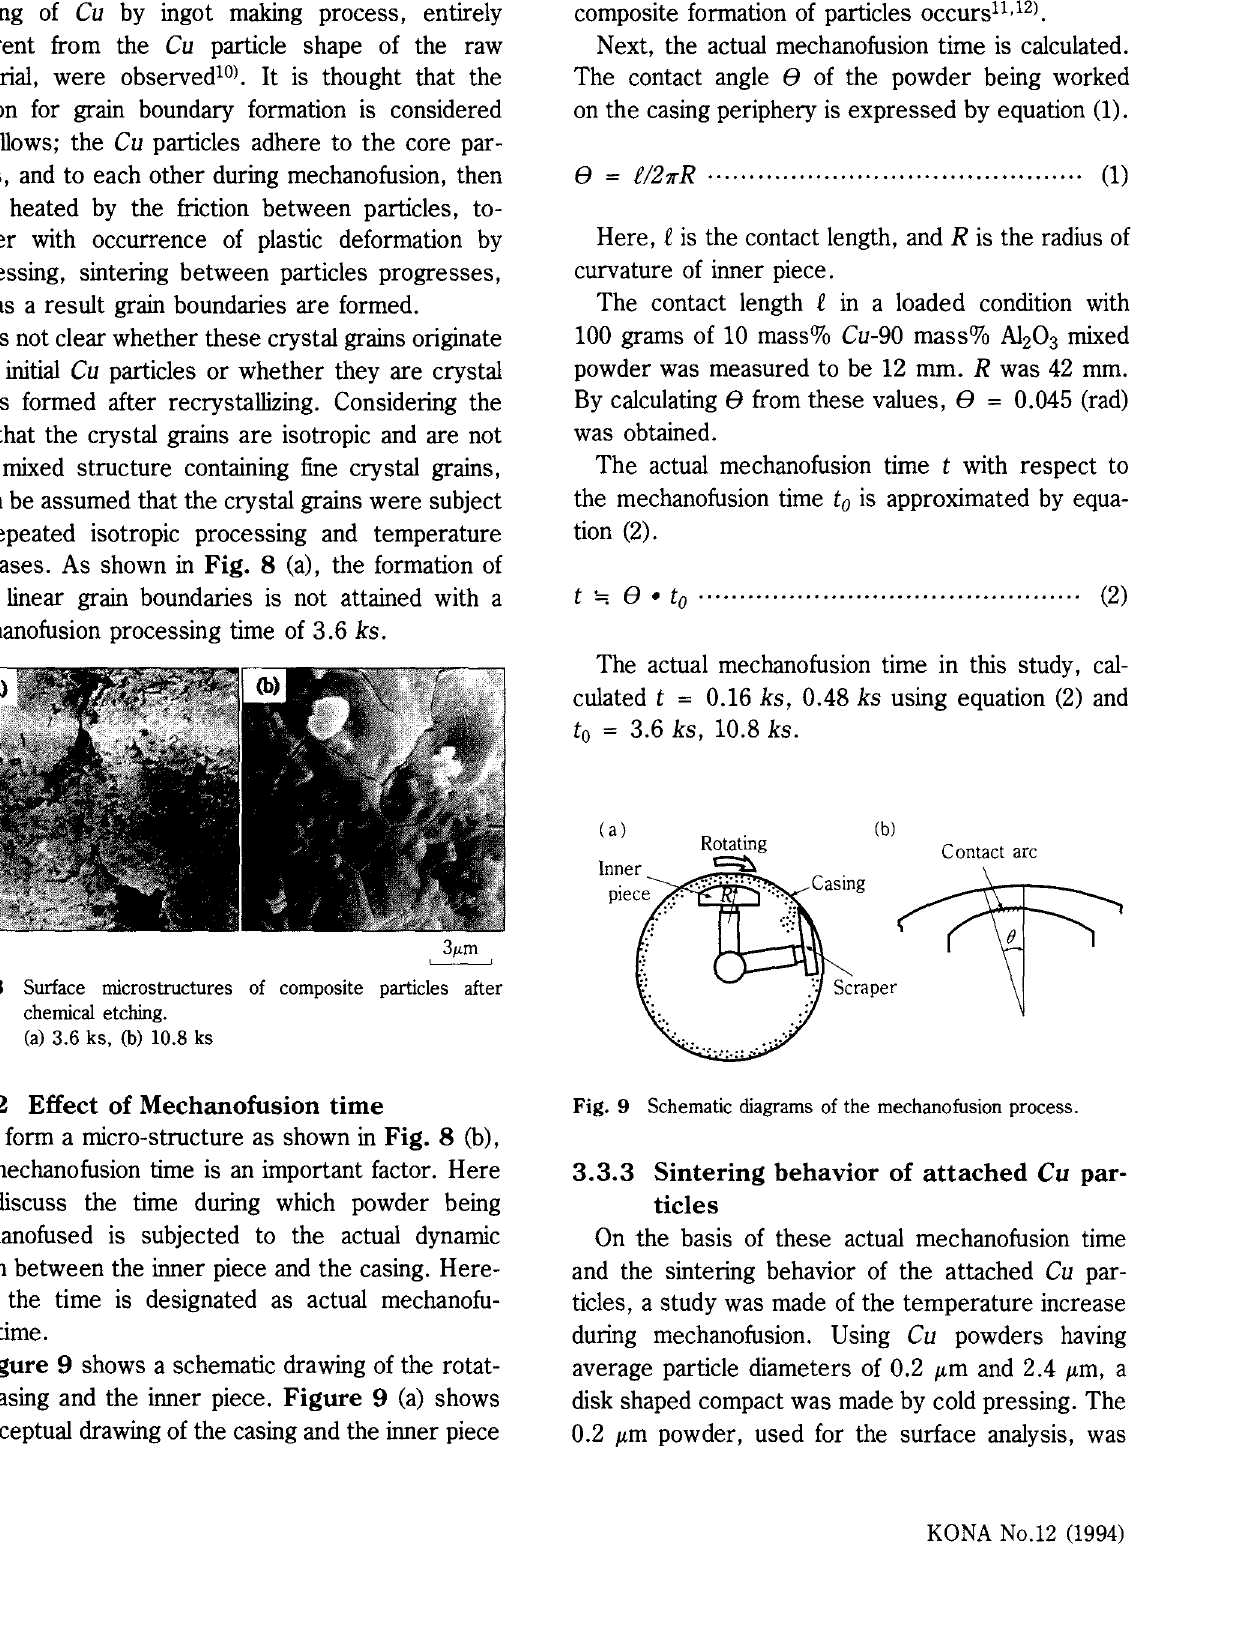
Fig. 8 Surface microstructures of composite particles after chemical etching. (a) 3.6 ks, (b) 10.8 ks